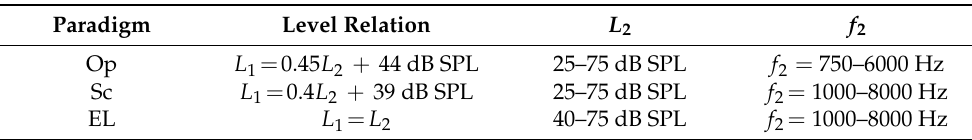
Table 1. The primary levels and frequency ranges of the three paradigms used in this study (i.e., Op, Sc, and EL). In all paradigms, f 2 / f 1 = 1.22 and L 2 changed in 5 dB increments. In the Sc paradigm, L 1 = L 2 for L 2 ≥ 65 dB